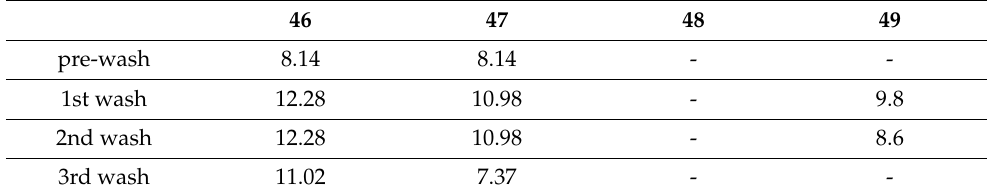
Table 4. pH of washing baths.